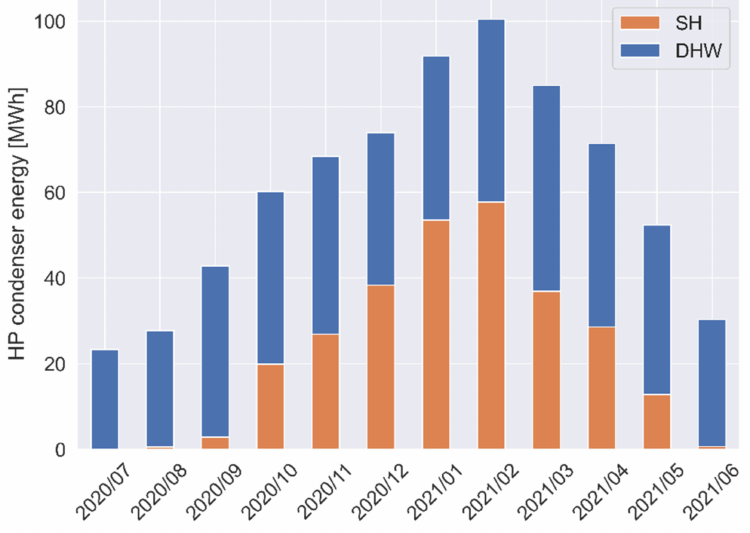
Figure 16. Heat pumps: monthly energy use in space heating (SH) and domestic hot water (DHW)